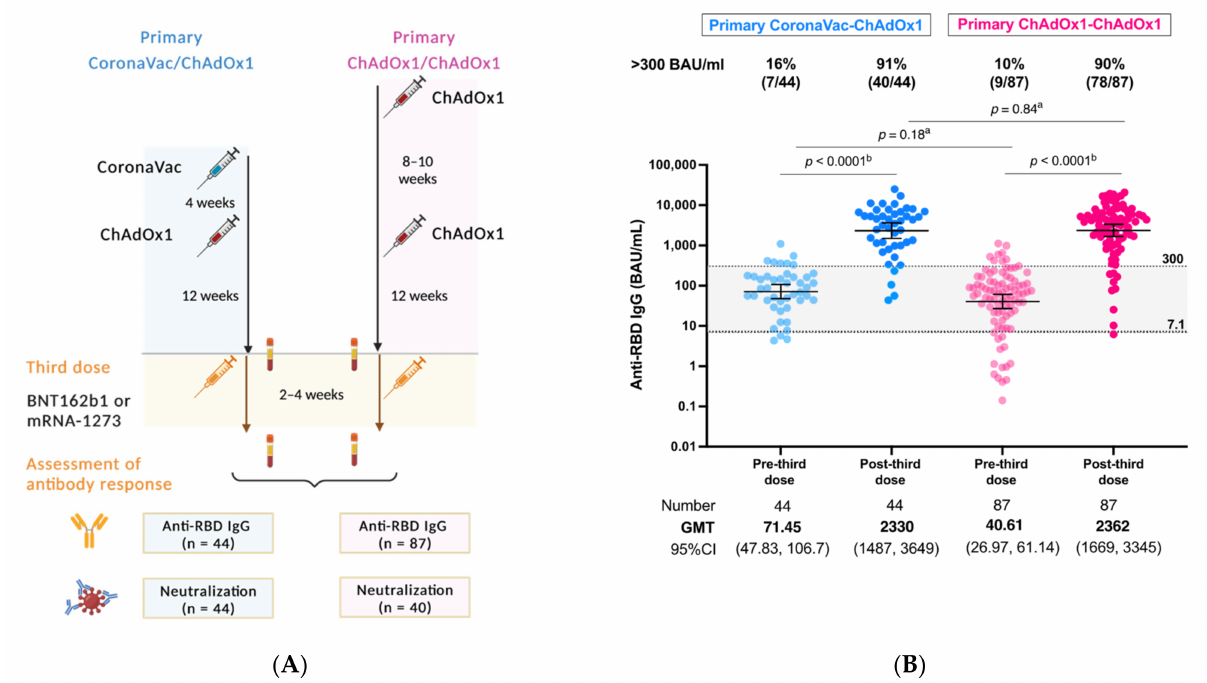
Figure 1. ( A ) Study flow diagram ( B ) SARS-CoV-2 binding antibody response at post-third mRNA COVID-19 vaccine following the primary heterologous CoronaVac/ChAdOx1 versus ChAdOx1/ChAdOx1 vaccination schedules. Anti-RBD IgG levels ≥ 7.1 BAU/mL (equal to 50 AU/mL) were considered positive, whereas levels >300 BAU/mL were considered as adequate response. a Mann-Whitney test, b Wilcoxon signed rank